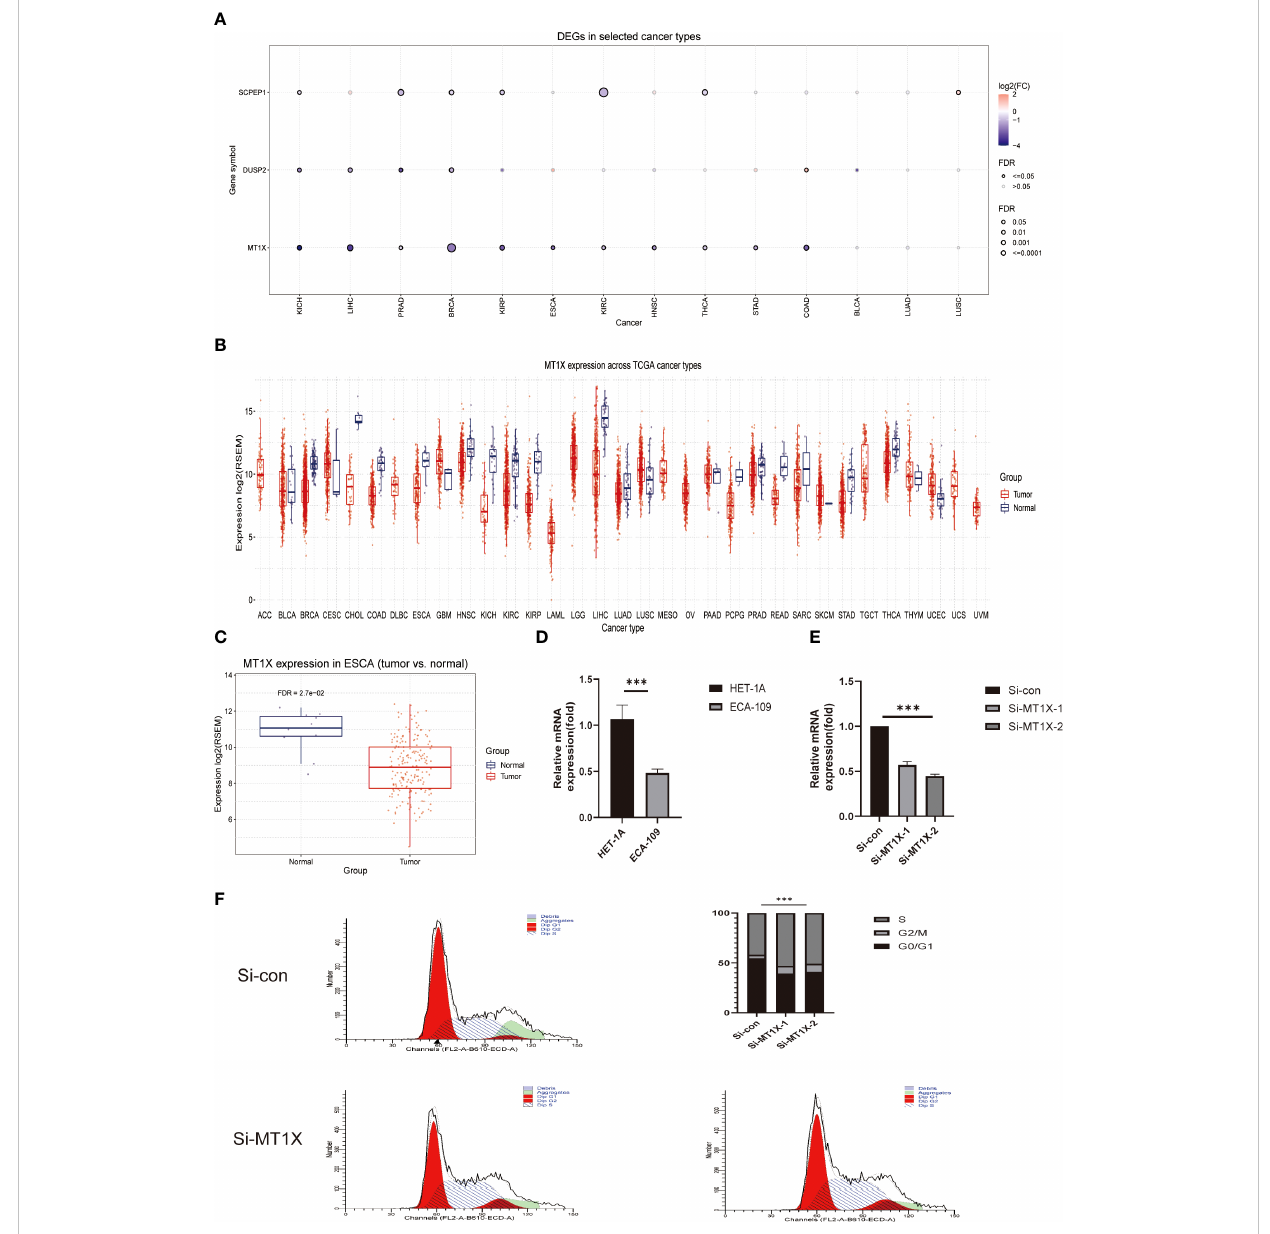
FIGURE 7 Cellular experimental validation of the role of MT1X, a key gene of the lysosomal pathway, in the growth and invasion of ESCC. (A) Box plot analysis reveals the number and signi fi cance of the four constitutive genes of the lysosomal pathway risk model in different tumours; (B) Box plot analysis of MT1X expression in different tumour types and paraneoplastic tissues, showing that MT1X gene expression was weaker in most tumour types than in paraneoplastic tissues, except for CESC, GBM, UCEC and LUSC (C) Box plot analysis of MT1X expression in tumour and normal tissues in ESCC, showing that MT1X expression in normal tissues was signi fi cantly higher than that in tumour tissues; (D) Cellular assays demonstrating the role of MT1X in the expression and growth invasion of oesophageal cancer cells: qPCR analysis of MT1X expression in ECA-109 and HET-1A cell lines; (E) qPCR analysis of MT1X expression in ECA-109 and HET-1A cell lines. qPCR con fi rmed the successful knockdown of MT1X in ECA-109 cells in two replicate sets; (F) Flow cytometry analysis of the cell growth cycle percentage of ECA-109 cell lines before and after MT1X knockdown. *** means